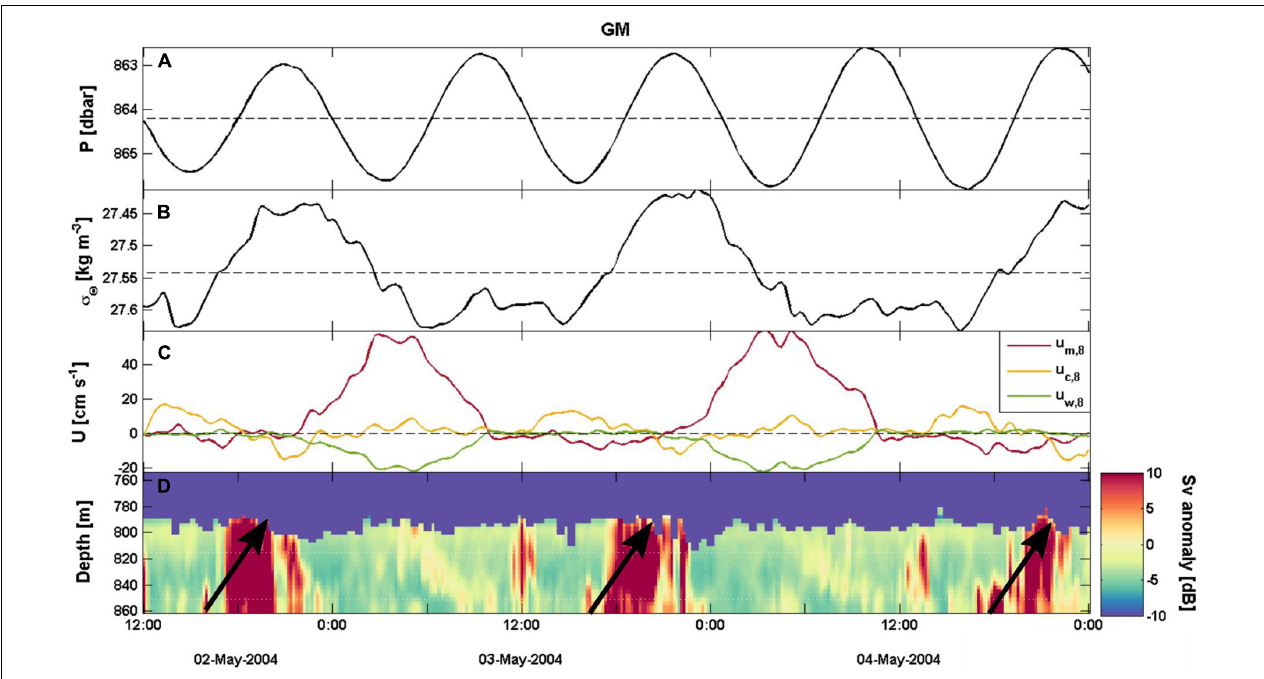
FIGURE 8 | Selected 2.5-days time series from Galway mound for (A) pressure, (B) sigma-theta, (C) velocity components for 8 masf (red: u m , yellow: u c , green: u w ), and (D) mean volume backscatter (Sv) anomaly showed as Hovmöller diagram (Høvmoller, 1949) with red (blue) representing stronger (weaker) than average